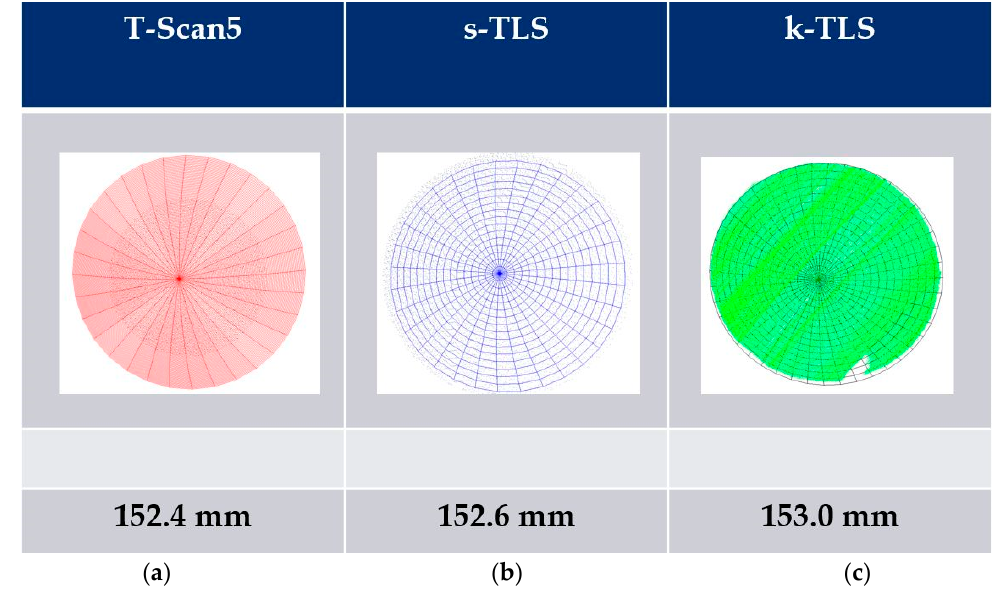
Figure 16. Focal length of paraboloid in mm derived from ( a ) T-Scan 5; ( b ) static and ( c ) k-TLS measurements calculated with Spatial Analyzer.